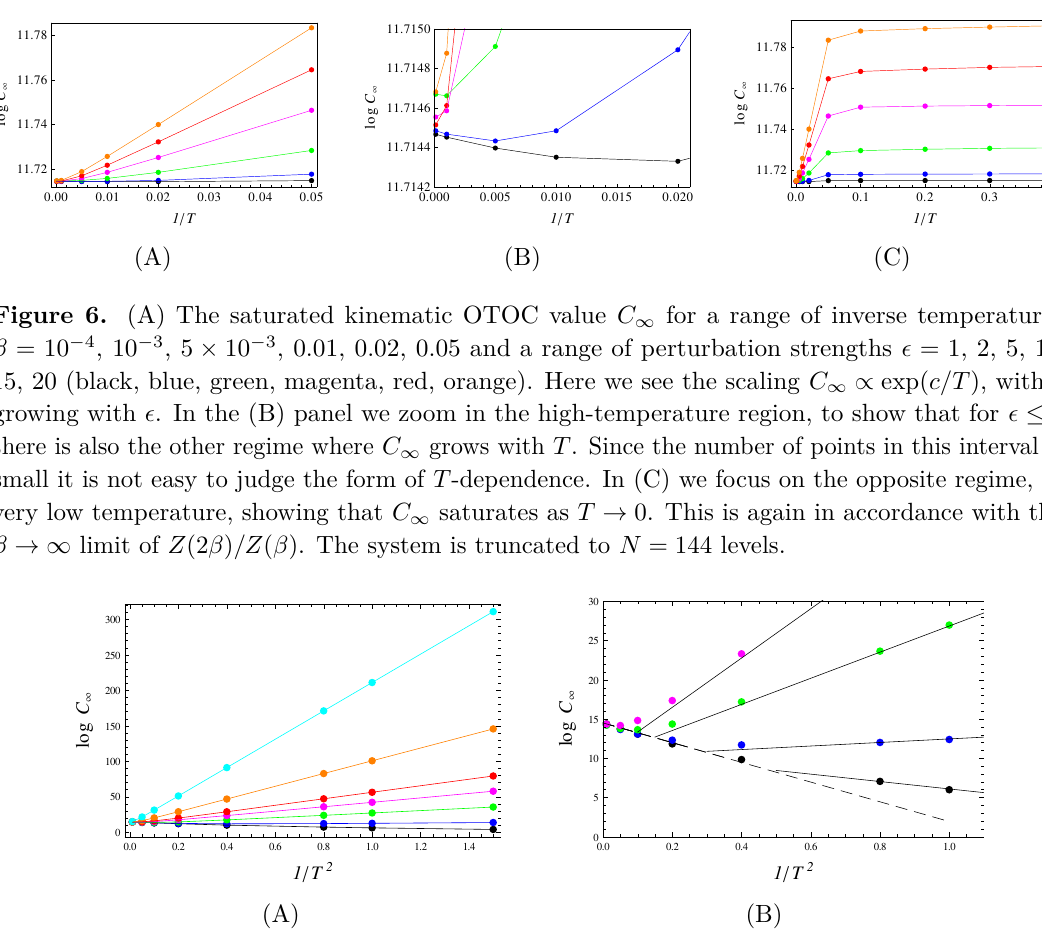
Figure 7. The saturated kinematic OTOC value C ∞ ( T ) for the truncated Henon-Heiles model with N = 25 levels. The perturbation strength is (cid:15) = 0 . 1 , 0 . 3 , 0 . 5 , 0 . 7 , 0 . 9 , 1 . 5 , 3 . 0 (black, blue, green, magenta, red, orange, cyan). Already in (A) we see that for (cid:15) ≤ 0 . 5 there is a finite crossover temperature T c so that C ∞ grows wth temperature for T > T c . Since T c goes down when the Hilbert space is reduced, we can observe the high-temperature regime very clearly and see that it collapses to a universal law C ∞ ∼ exp( − 4 π/T ) . This is seen in the panel (B) where we zoom in at the interesting